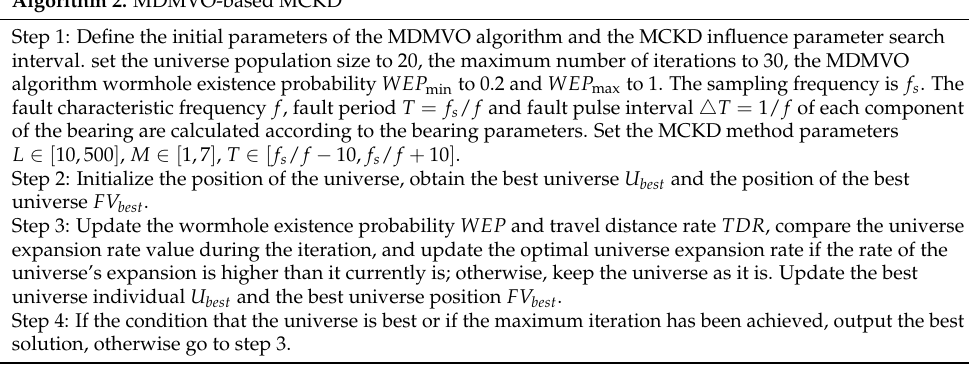
Algorithm 2. MDMVO-based